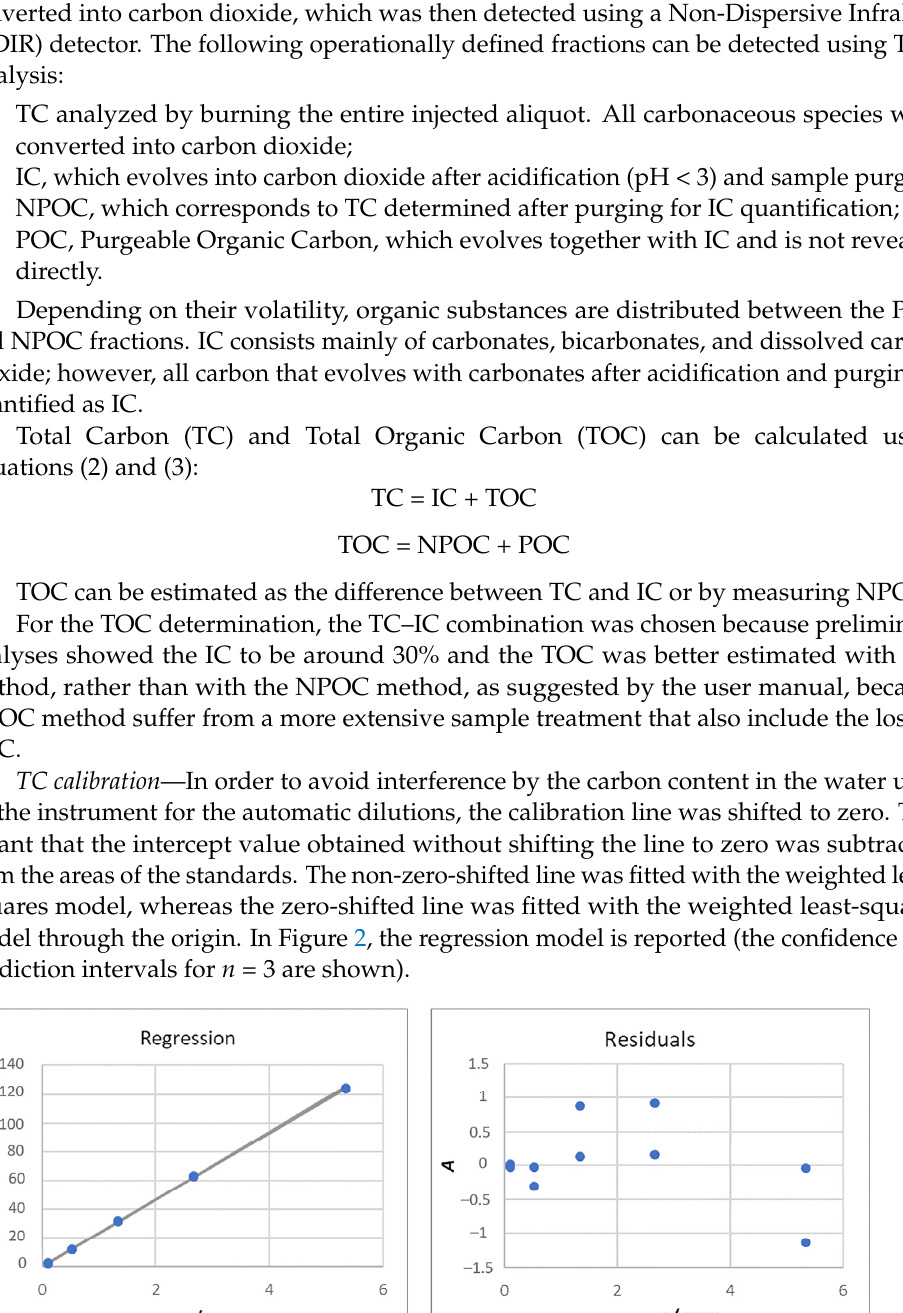
The linearity of the calibration curve was evaluated using the lack-of-fit test (alpha 0.01, ISO 11095:1996), Mandel’s test (alpha 0.01, ISO 8466-1:2001), and the 5%-interval test (EN 15984:2022). The aforementioned tests yielded positive results. Moreover, the R 2 value was 0.9999 and the cross-validated R 2 was 0.9999. Considering 3 independent determinations for the samples, the LOD (4s0) was 0.02 ppm and the LOQ (3LOD) was 0.05 ppm (ISO 13530:2009). IC calibration —The same procedure followed for TC calibration was used. The instru- ment was used in the high-resolution mode and the injection volume used was 1000 µL. The IC purging time was set to 2 min. In Figure 3, the regression model is reported.